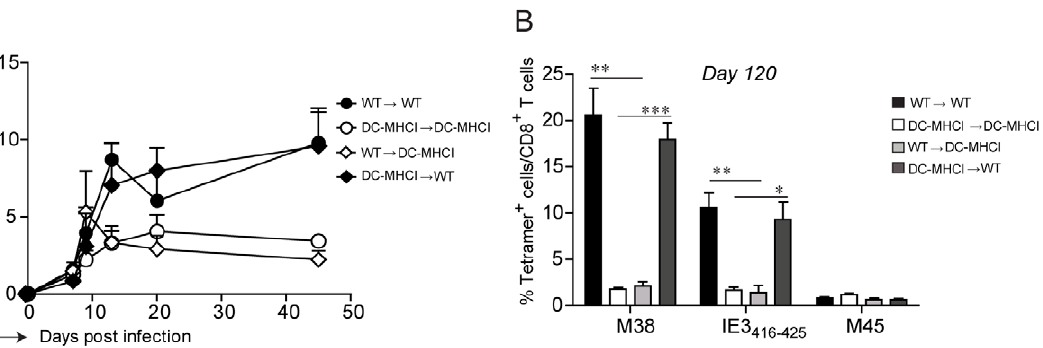
Figure 4. Restriction of antigen presentation to DCs abrogates memory inflation. WT R WT, DC-MHCI R DC-MHCI, WT R DC-MHCI, DC- MHCI R WT chimeric mice were generated by reconstituting WT and DC-MHCI irradiated mice with WT and DC-MHCI bone marrow. All groups (3–5 mice per group) were infected with MCMV- D m157 and the M38-specific CD8 T cell response was measured by tetramer staining from blood samples obtained on days 7, 9, 13, 20 and 45 post infection (A). The experiment was terminated on day 120 post infection and M38-, IE3-, and M45-specific CD8 T cell responses were quantified in the lungs by tetramer staining (B). One of two independent experiments is shown. Significances were analyzed by Student’s t test. *, P , 0.05; **, P , 0.01; *** P ,